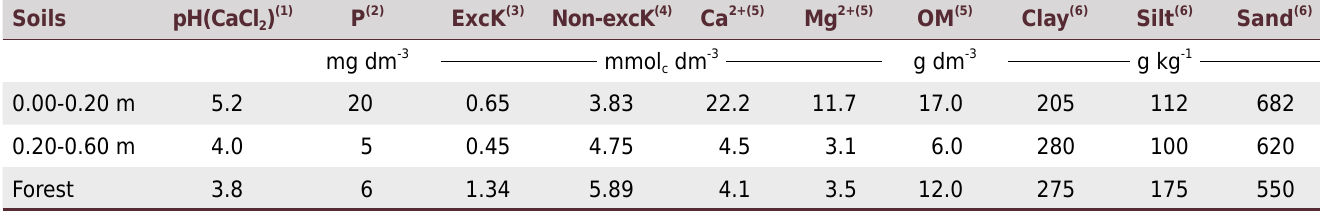
Table 1. Selected soil chemical properties and particle size distribution Soils